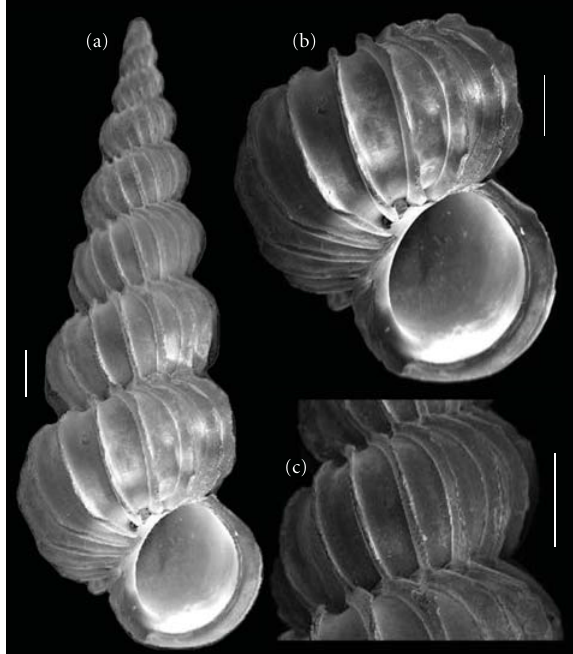
Figure 1: (a–c) Epitonium fractum (LMUFRPE); (a) ventral view, (b) view of last whorl, and (c) detail of teleoconch ornamentation. Scale bars: (a–c) 500 μ